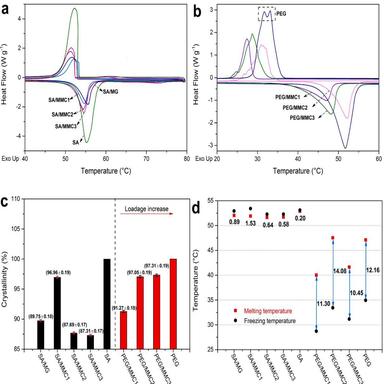
DSC curves of (a) SA, SA/MG, and SA/MMCs, (b) PEG and PEG/MMCs; (c) Supercooling degree, (d) Crystallinity.